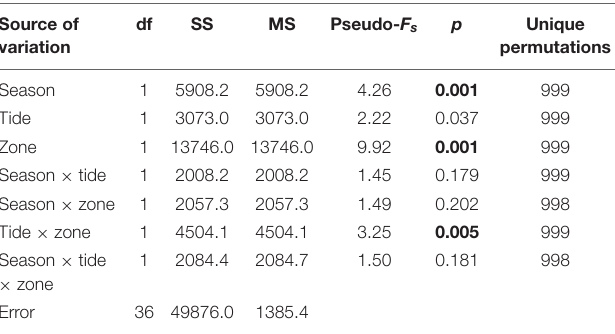
TABLE 3 | PERMANOVA of the fish community composition according to season, tide, and zone, based on logarithmically transformed data. Source of df SS MS Pseudo- F s p Unique variation